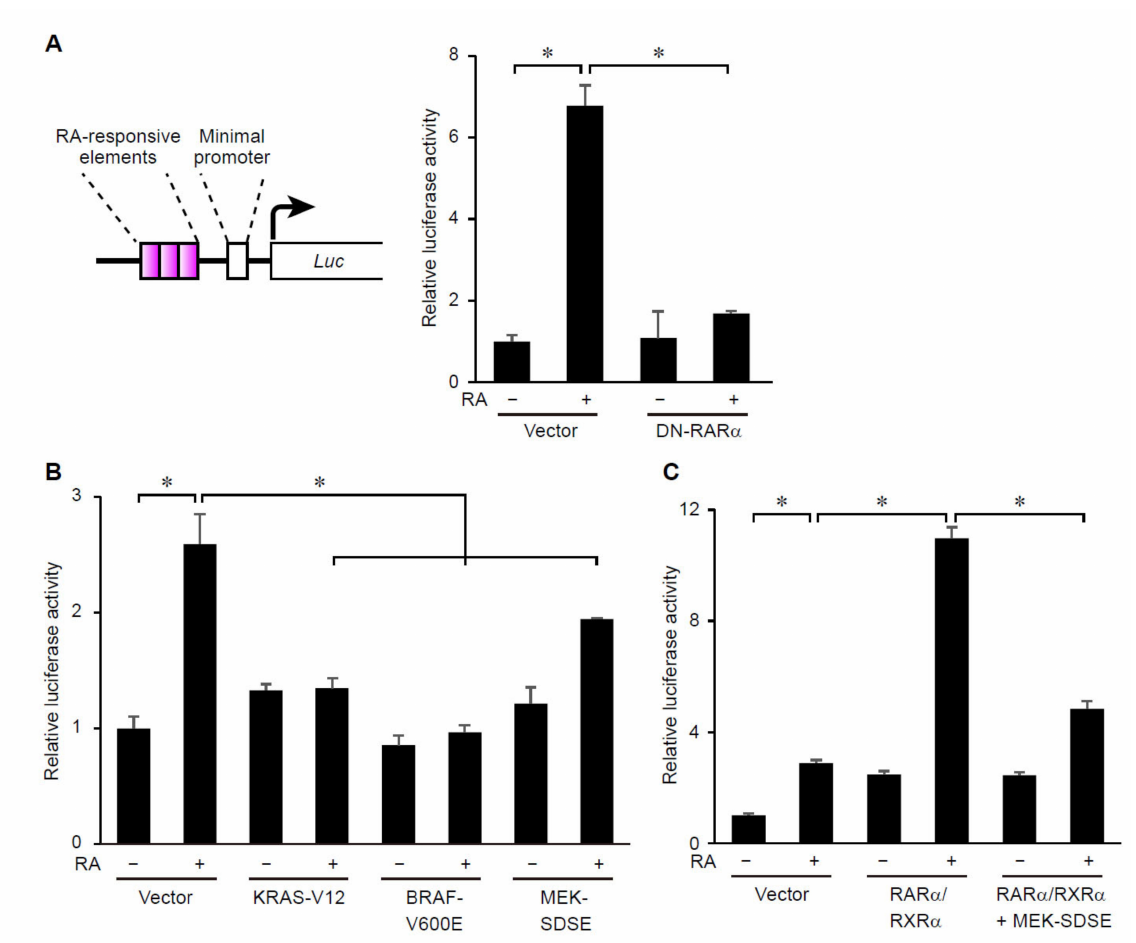
Figure 3. Activation of RAS-ERK signaling suppresses transcriptional activity of RARs. ( A – C ) The RARE reporter assays to measure transcriptional activity of RAR ( A , left) was performed in MCF7 cells. (left) Schematic representation of the RAR reporter construct in which transcription of the luciferase gene (indicated by arrow) was regulated by a minimal promoter and triplicated RAREs (whose locations are indicated by dot lines). Cells were transfected with empty vectors, or expression plasmids for DN-RAR α , KRAS-V12, BRAF-V600E, MEK-SDSE, wild type RAR α and/or RXR α . Cells were treated with 1 µ M of RA for 18 h prior to the measurements. *, p < 0.05 (one-way